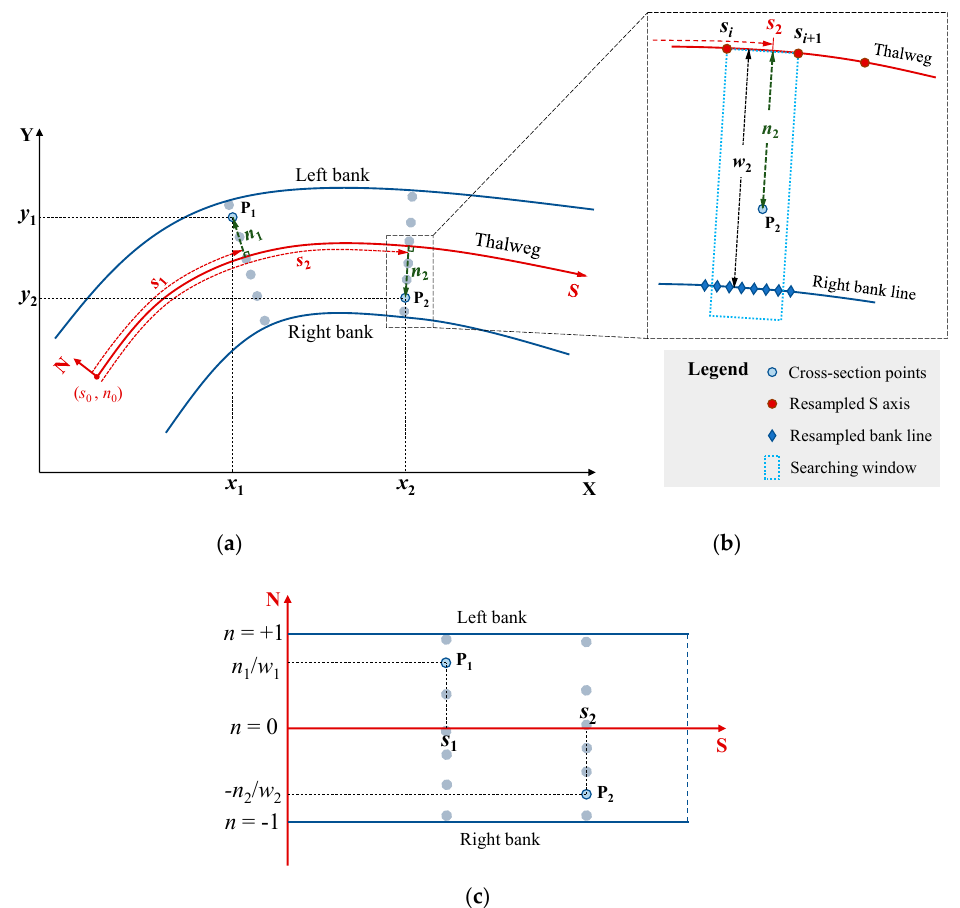
Figure 1. ( a ) Schematic display of the coordinates transformation from Cartesian X-Y coordinates to the curvilinear orthogonal S-N coordinate system with dimensionless channel width (DCW) processing; ( b ) Inset for coordinates transformation of an arbitrary point P 2 in (a), with digitized and resampled thalweg and river bank line. It should be noted that the bank line in this paper is specified as the edge of the water body; ( c ) River channel with dimensionless width after the coordinates transformation.